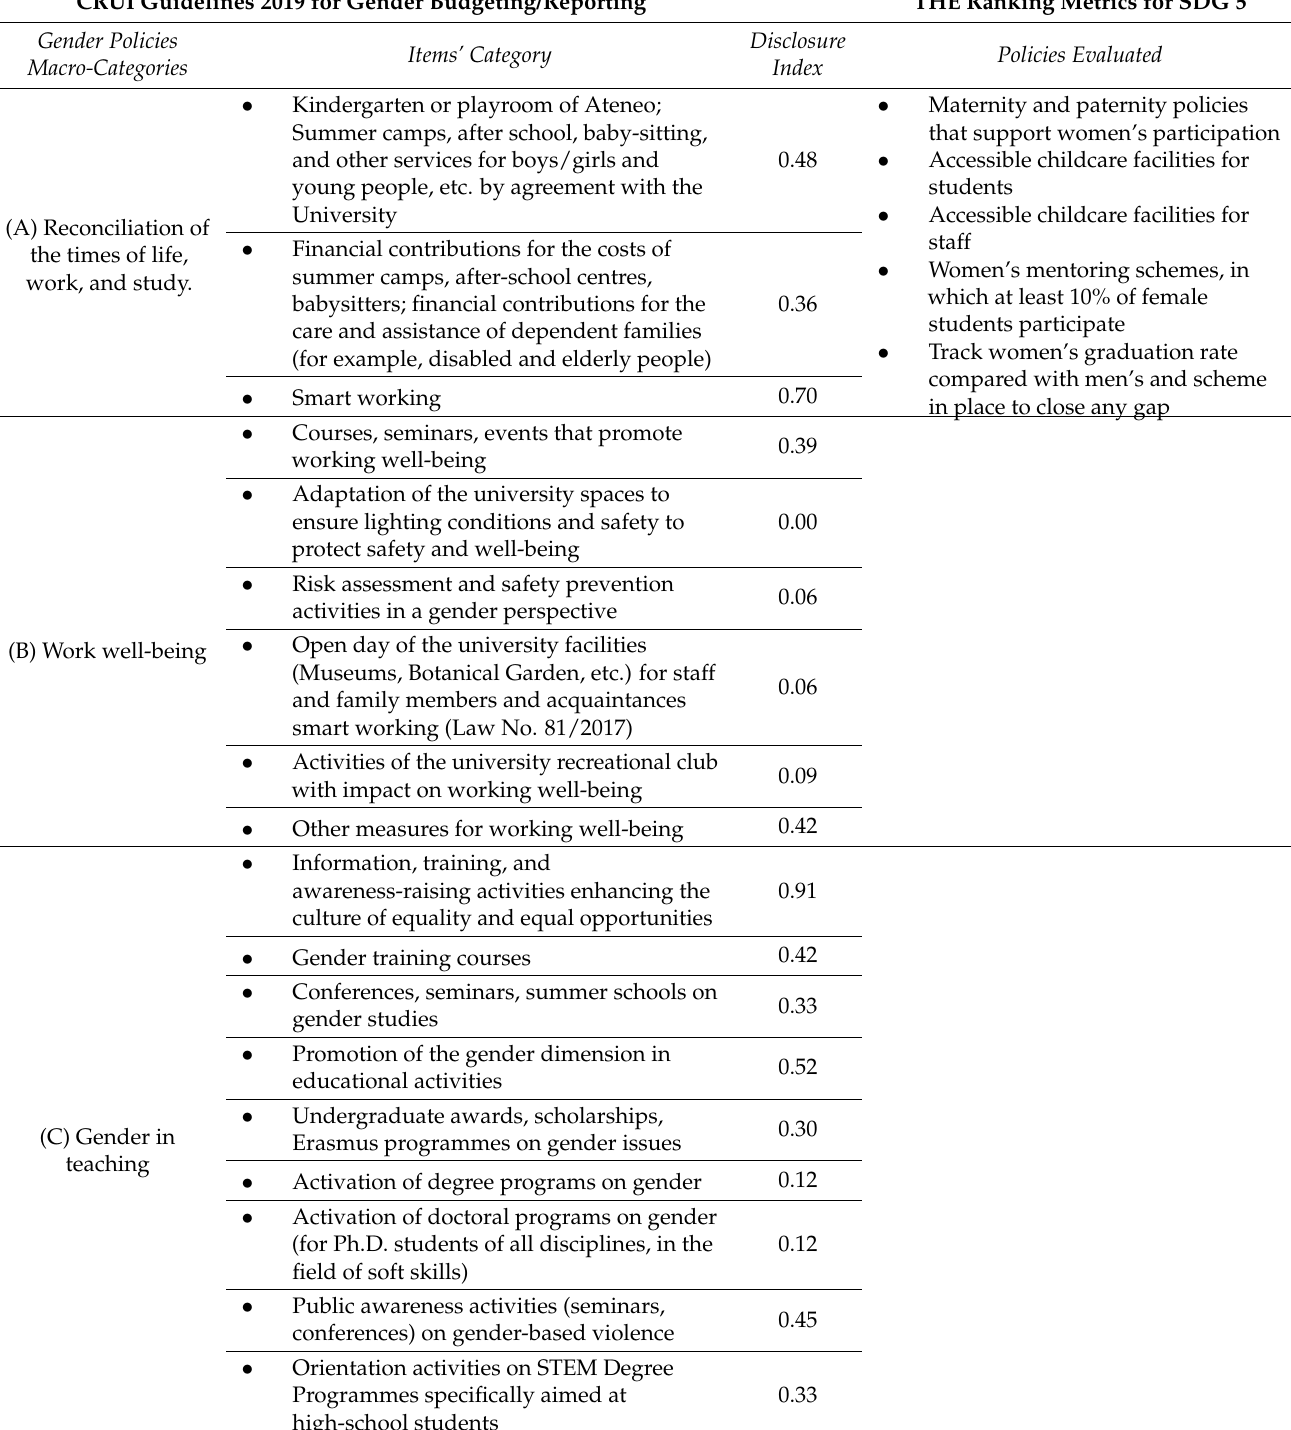
Table 4. The level of the items categories about the gender policies disclosed by Italian universities vs. policies contemplated in THE